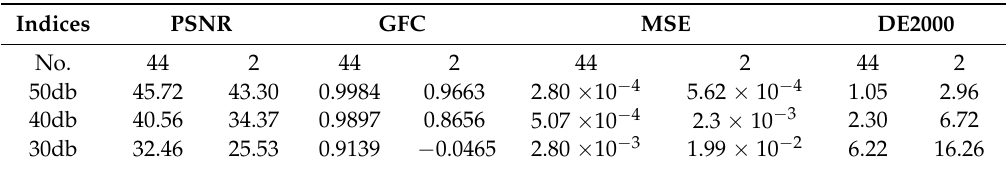
Table 3. Comparison of the performances between the best-performed filter set No. 44 and the traditional suboptimal selection No. 2 at 6